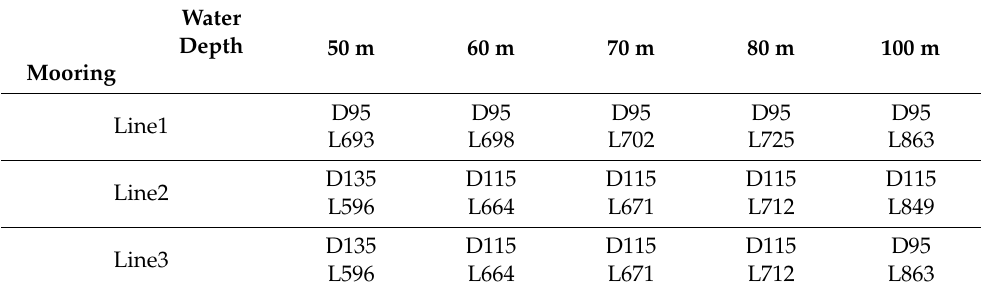
Table 9. The final mooring system design for the studied water depth (unit: D (mm), L